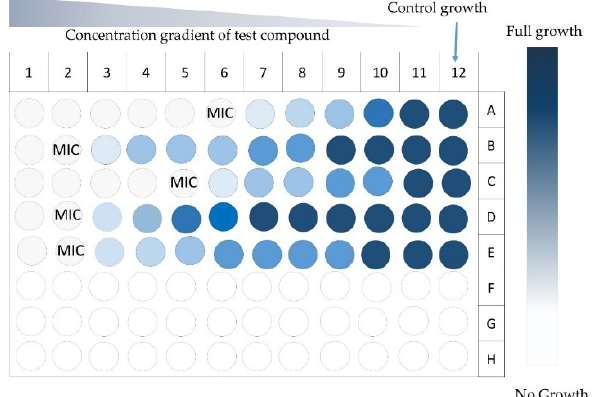
Figure 8. A 96-well plate showing results of the broth microdilution method for an antimicrobial test and minimum inhibitory concentration (MIC); © Authors.